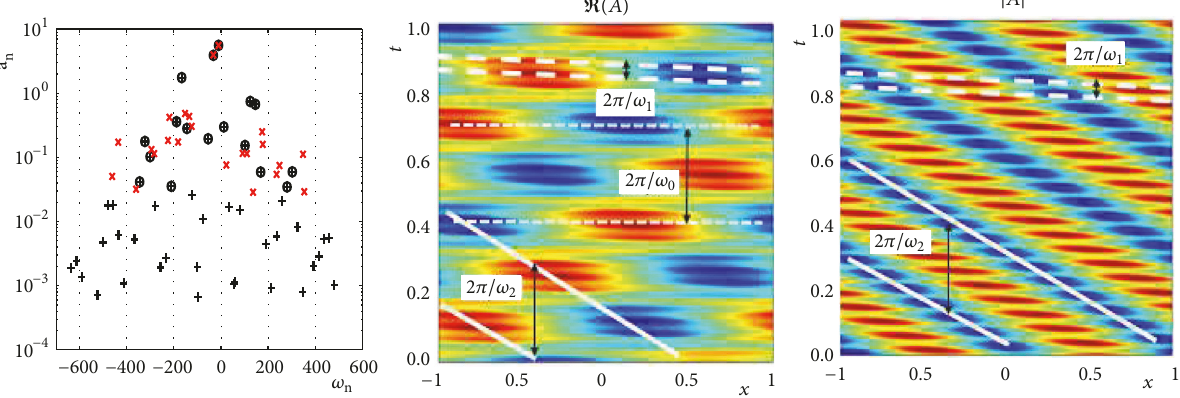
Figure 4: Counterpart of Figure 3 for = 22